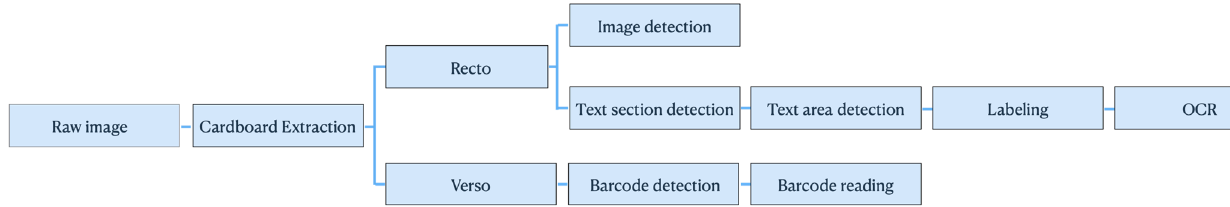
Figure 5. Document Digitisation Pipeline.